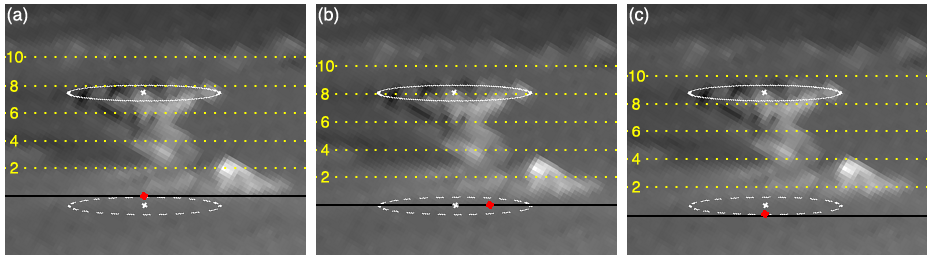
Figure 3. Effect of shifting the plane of isoheights, illustrated on the 19:10UTC GOES-17 band 2 image of the 8 April 2020 eruption of Sheveluch. In all three panels the solid white line is the circular fit to the umbrella cloud from Fig. 2d, and the dashed white line is the surface projection of that fit. The baseline (zero line) of the isoheights (red diamond and black line) is fixed to (a) the westernmost point of the surface-projected fit, (b) the volcano base (default) or equivalently the center of the surface-projected fit, and (c) the easternmost point of the surface-projected fit. Shifting the plane of the isoheights in panels (a) and (c) back and forth compared to panel (b) roughly accounts for the westward/eastward expansion of the far side/near side of the umbrella cloud. With such base adjustments, the isoheights consistently indicate an elevation of ∼ 8km for the middle as well as the edges of the umbrella